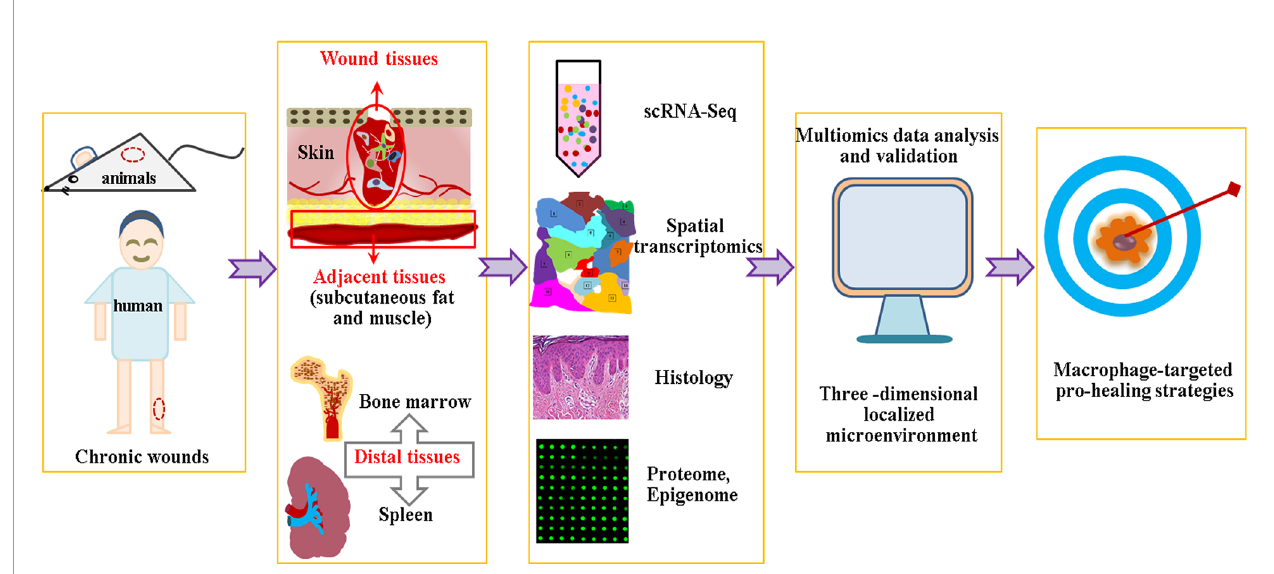
FIGURE 3 | Multiomics data analysis based macrophage speci fi c